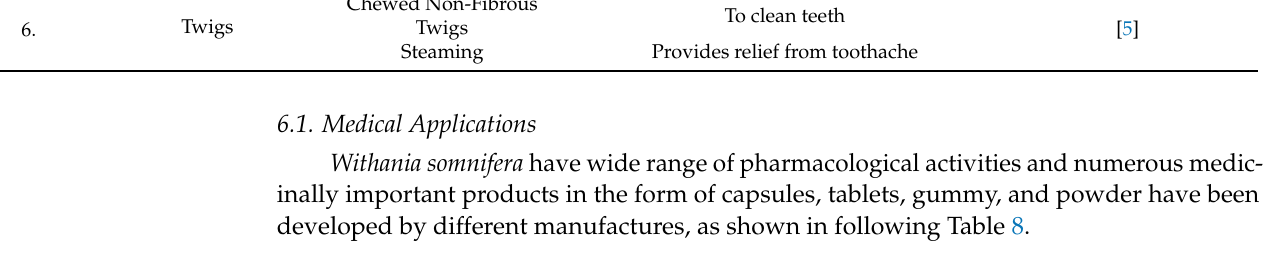
Table 8. Different manufactures marketing Withania -based formulations in the medical